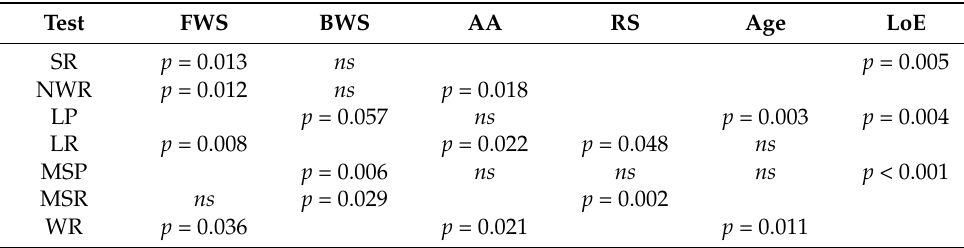
Table 5. Summary of the predictors involved in best fit models assessing the predictive role of executive functions and individual variables on